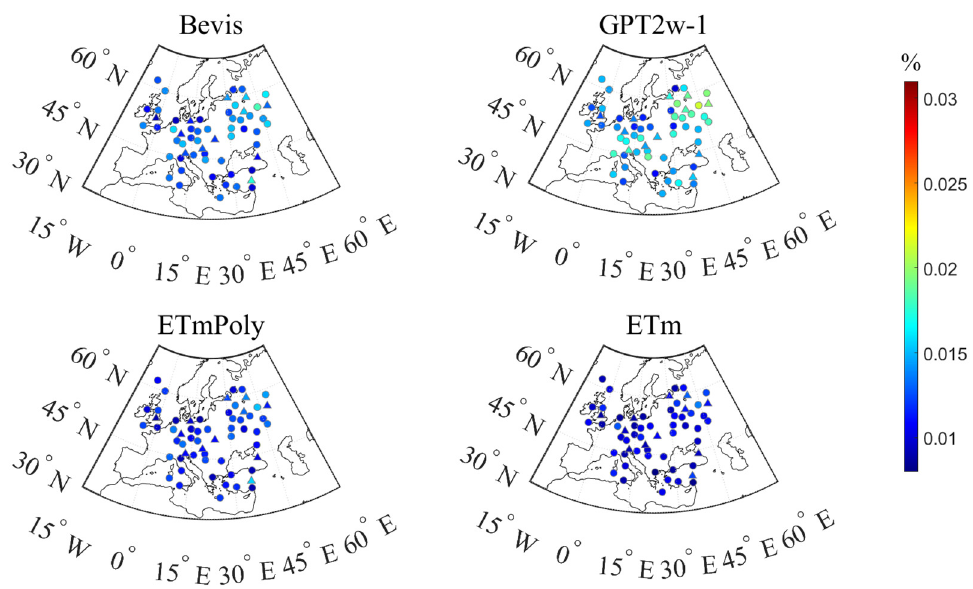
Figure 10. The theoretical relative error of PWV resulting from four different models using radiosonde data in